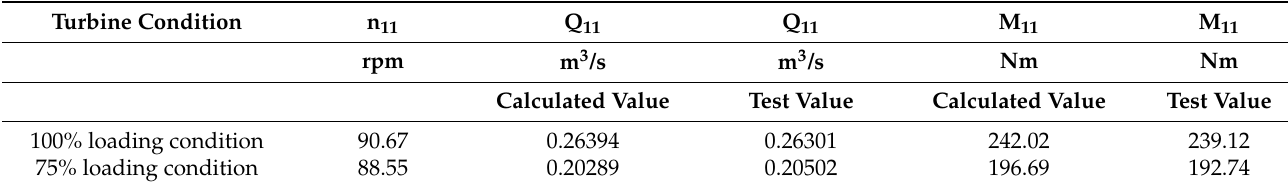
Table 4. Comparison of calculated and test